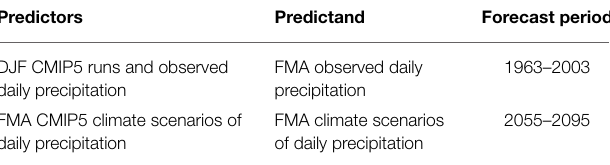
TABLE 2 | Design of the statistical downscaling with the ANN